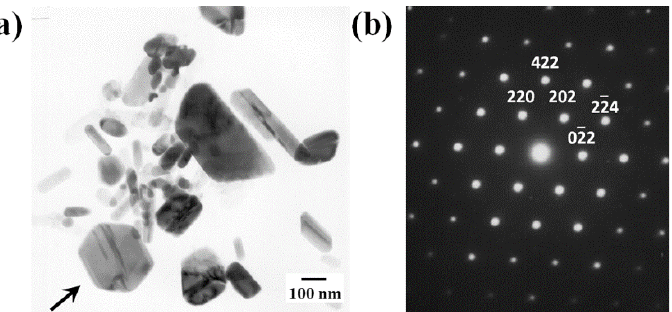
Figure 8. ( a ) TEM micrograph of M 23 C 6 carbide with ( b ) electron diffraction pattern with ZA = [26(cid:3364)1] .